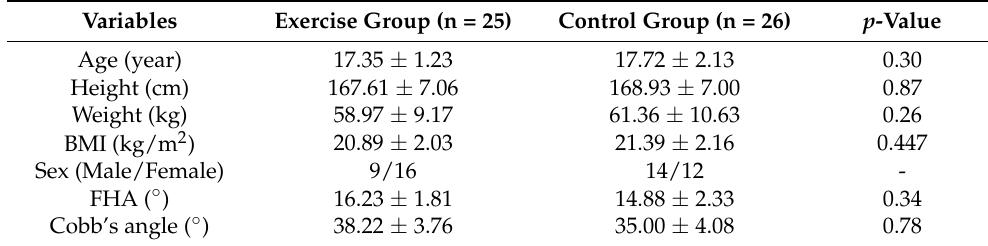
Table 1. Physical characteristics of the